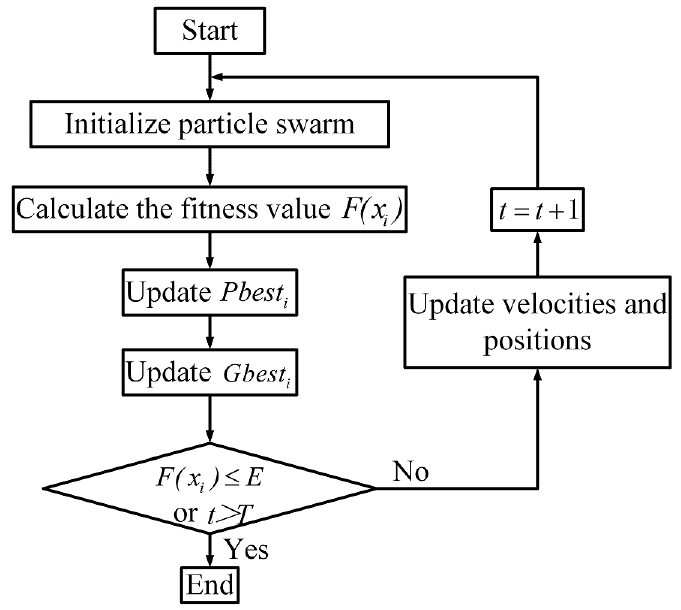
Figure 3. The flow of PSO.